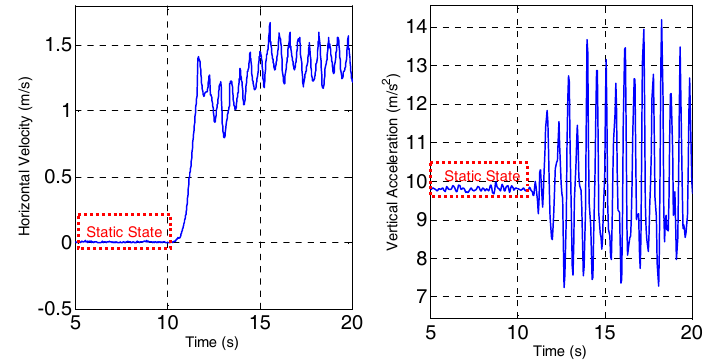
Figure 2. Horizontal velocity ( left ) and vertical acceleration ( right ) during static state and walking.